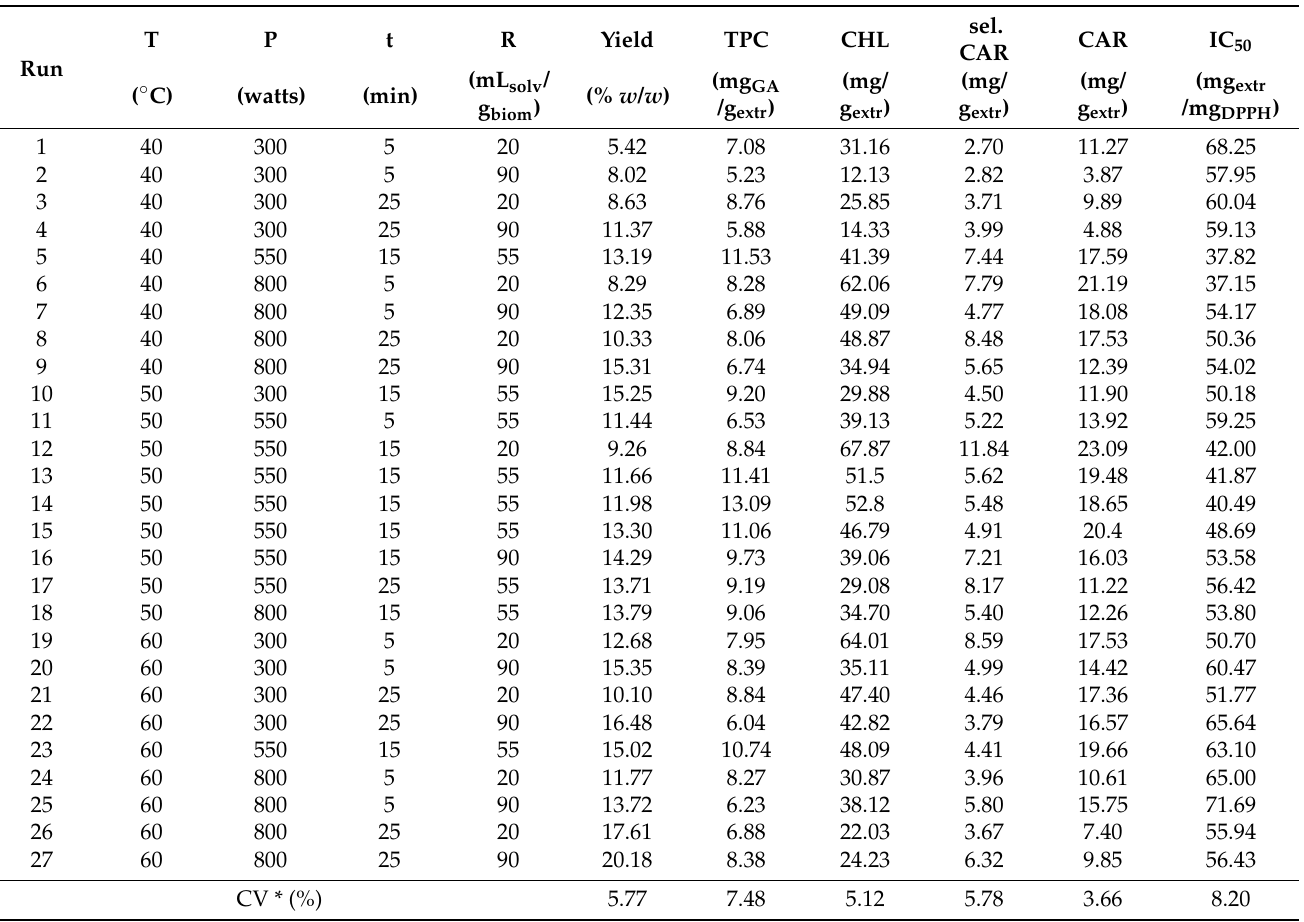
Table 2. Experimental conditions and results of MAE of C. vulgaris regarding yield, total phenolic (TPC), chlorophyll (CHL), selected carotenoid (sel. CAR), carotenoid content (CAR) and antioxidant activity (IC 50 ), according to the applied experimental design.